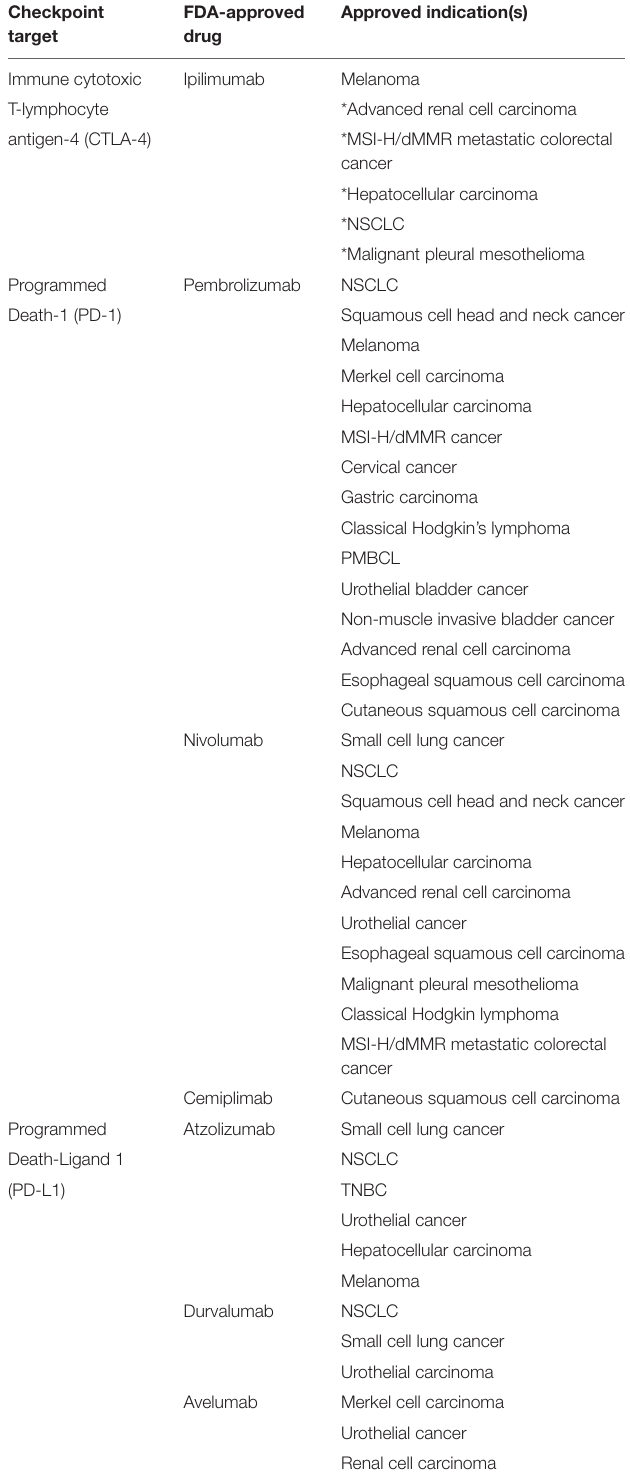
TABLE 1 | The FDA-approved immune checkpoint inhibitors and their approved